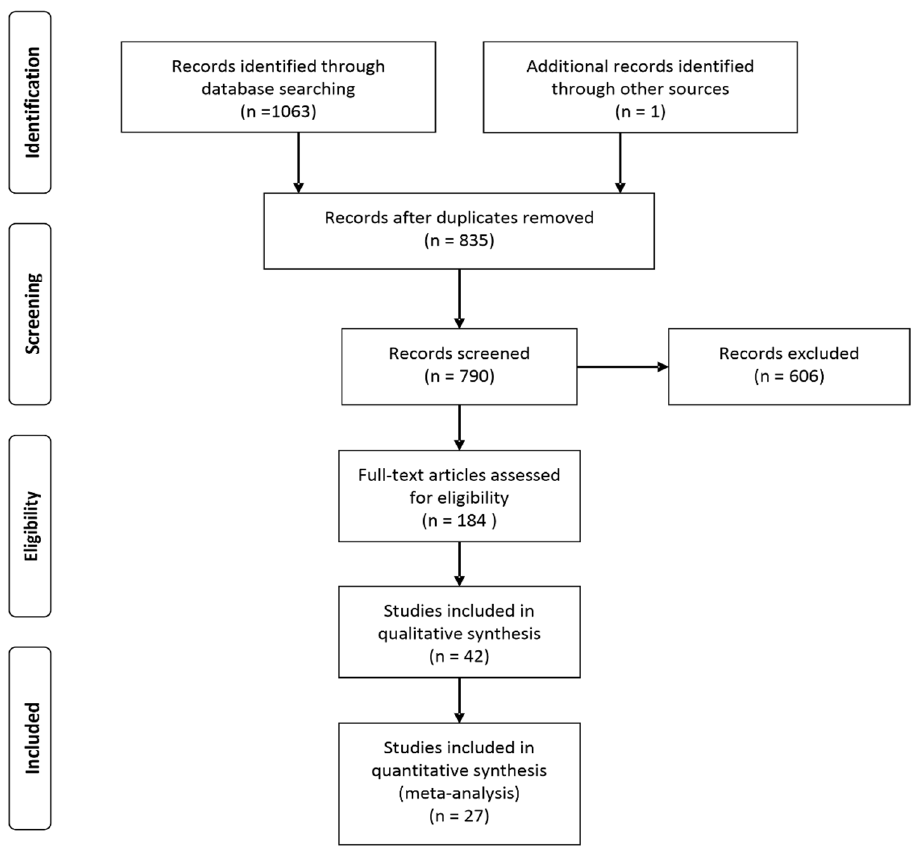
Figure 1. Flowchart for the selection and inclusion of records using the PRISMA protocol [22].